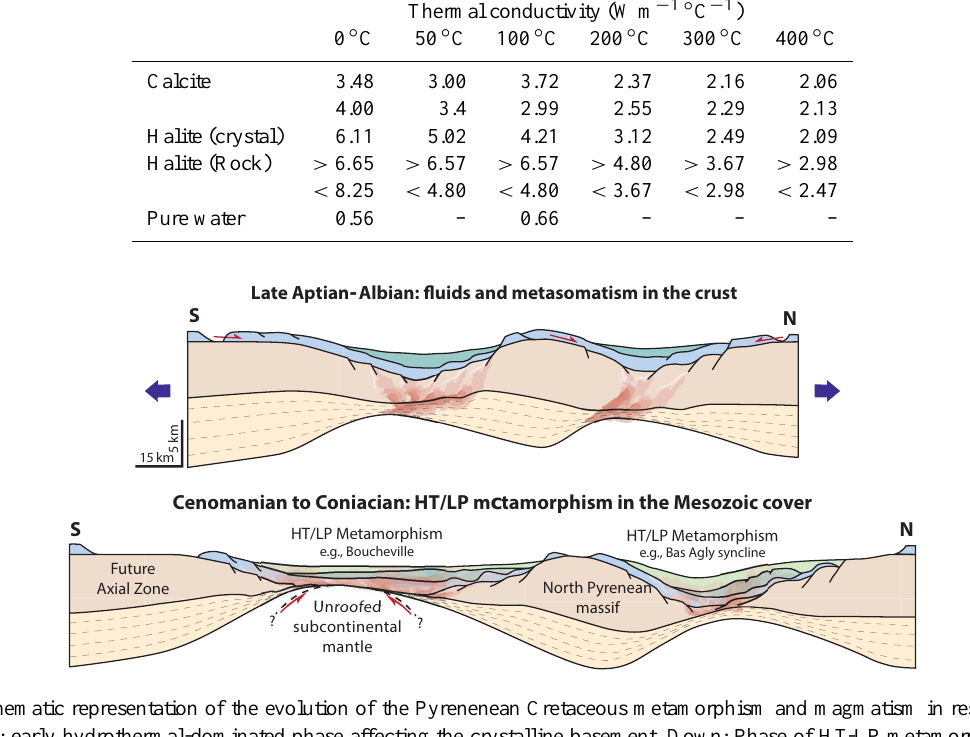
11 Hot versus cold